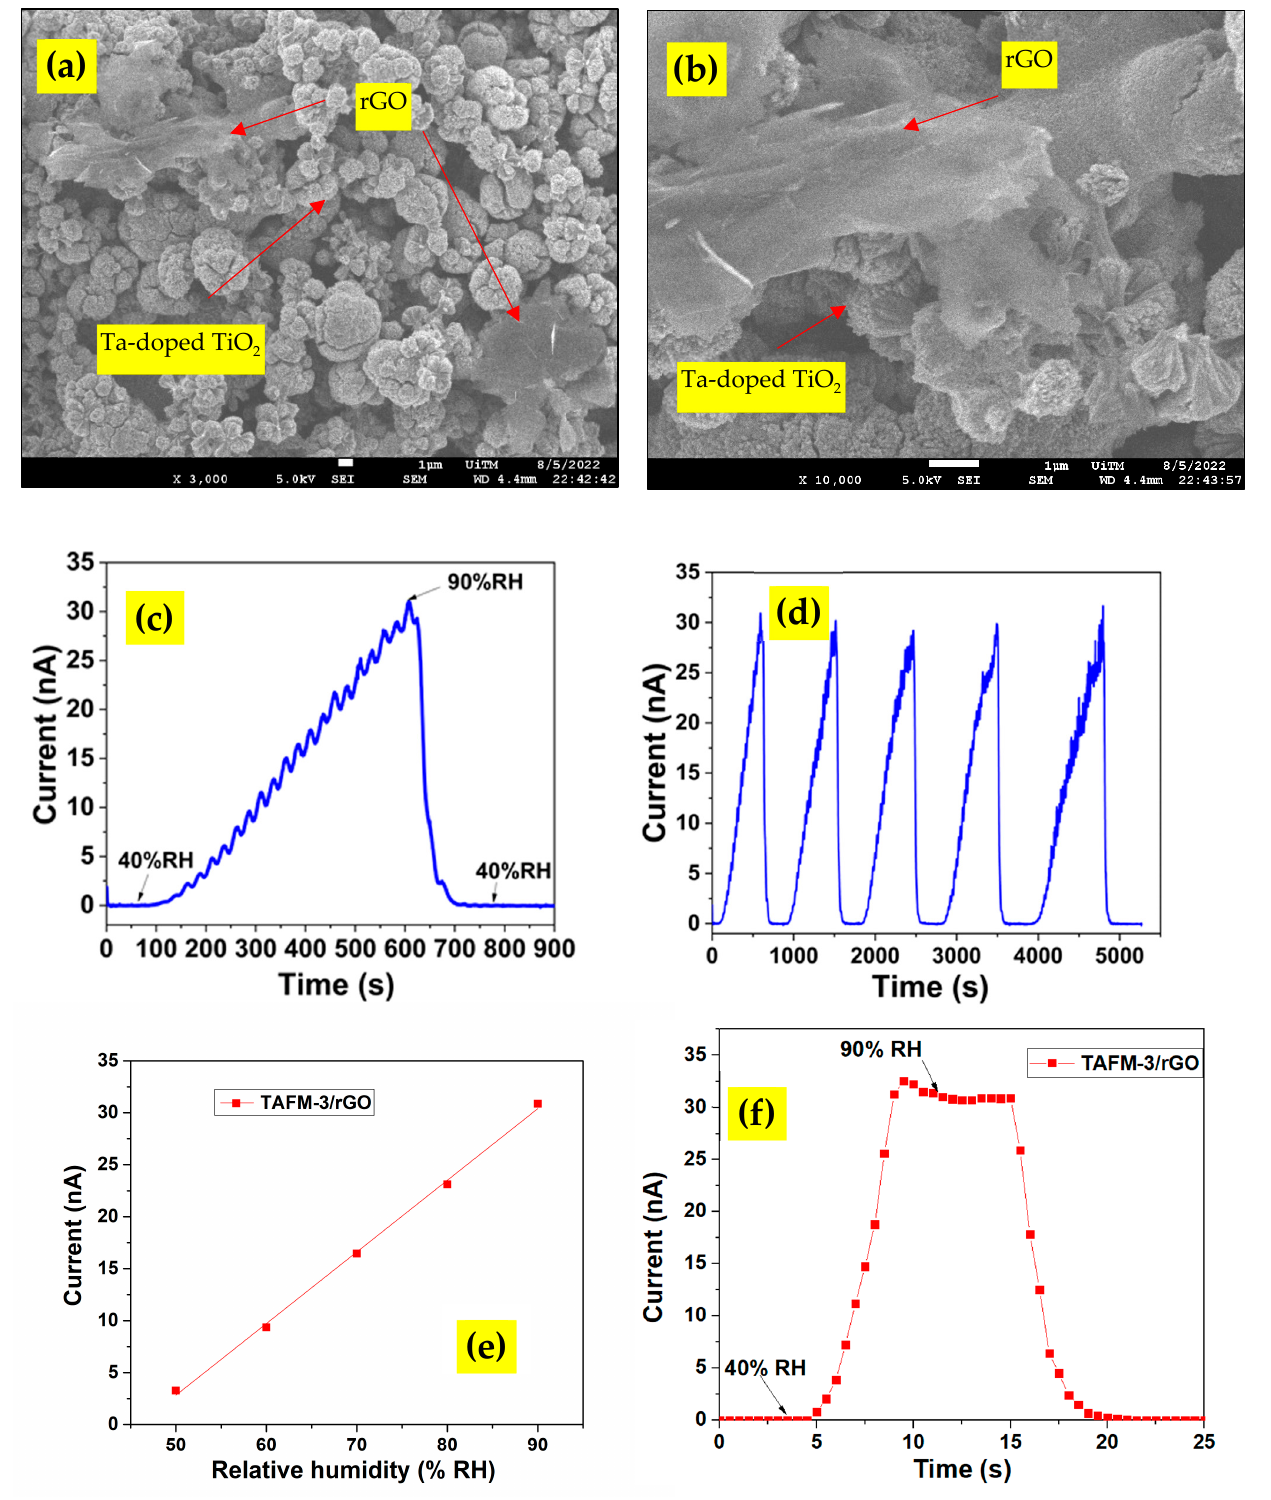
Figure 9. FESEM images of TAFM-3/rGO nanocomposite at ( a ) 3000 times magnification, and ( b ) 10,000 times magnifications, and ( c ) humidity response of Ta-doped TiO 2 /rGO composite. ( d ) Five-cycle reliability measurement of sensor response of Ta-doped TiO 2 /rGO nanocomposite-based humidity sensor. ( e ) Static response of humidity sensor based on TAFM-3/rGO nanocomposite. ( f ) Transient response plot of humidity sensors based on TAFM-3/rGO nanocomposite to humidity change between 40% RH and 90%